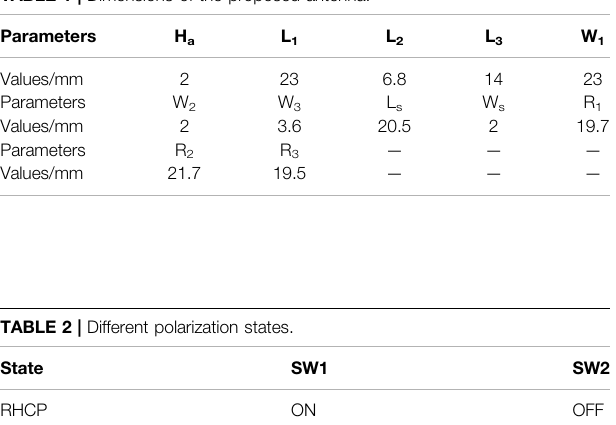
TABLE 1 | Dimensions of the proposed antenna.